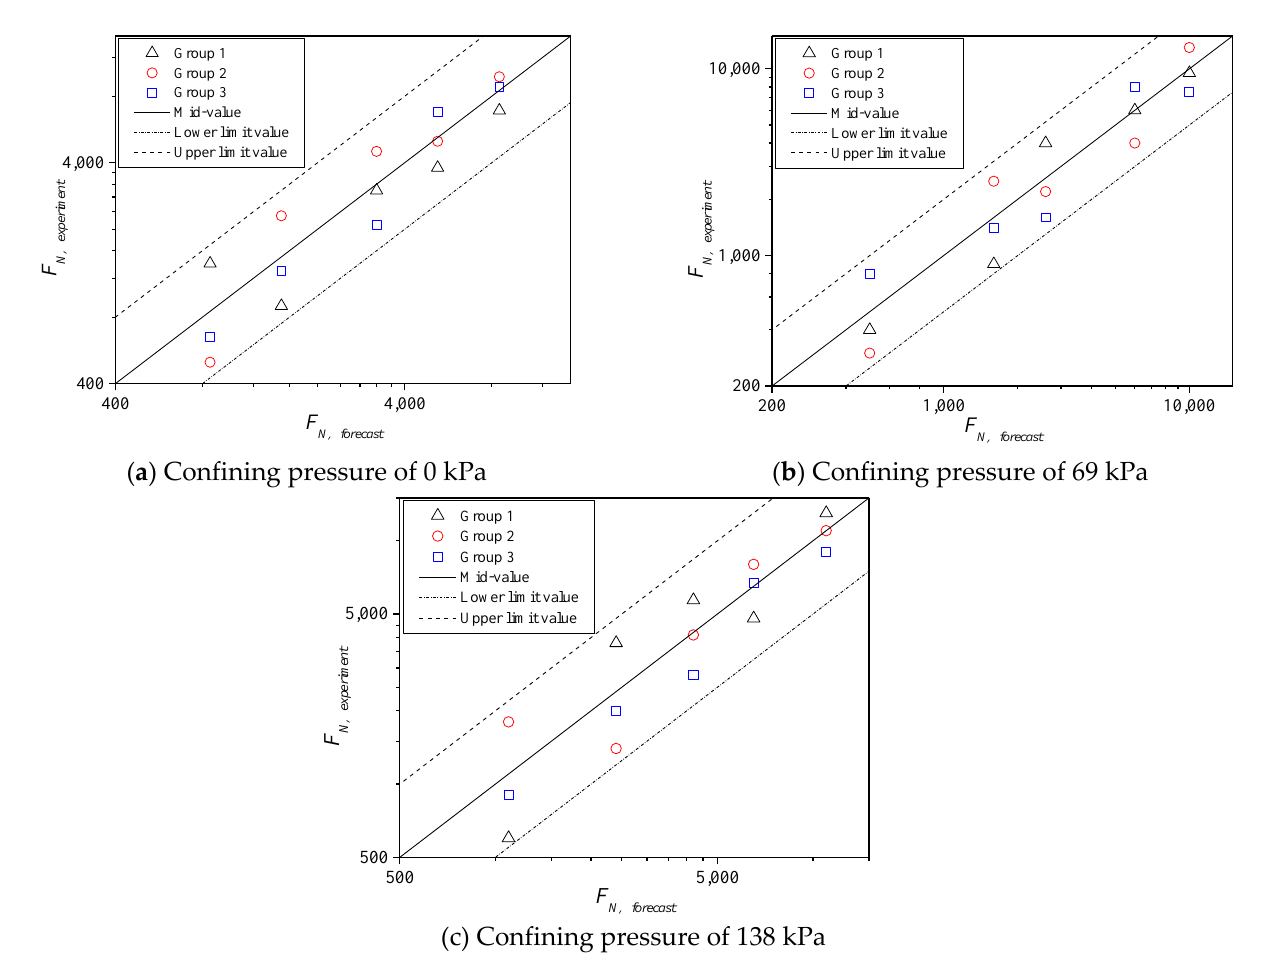
Figure 11. Validity of F N under different confining pressure at 60 °C.